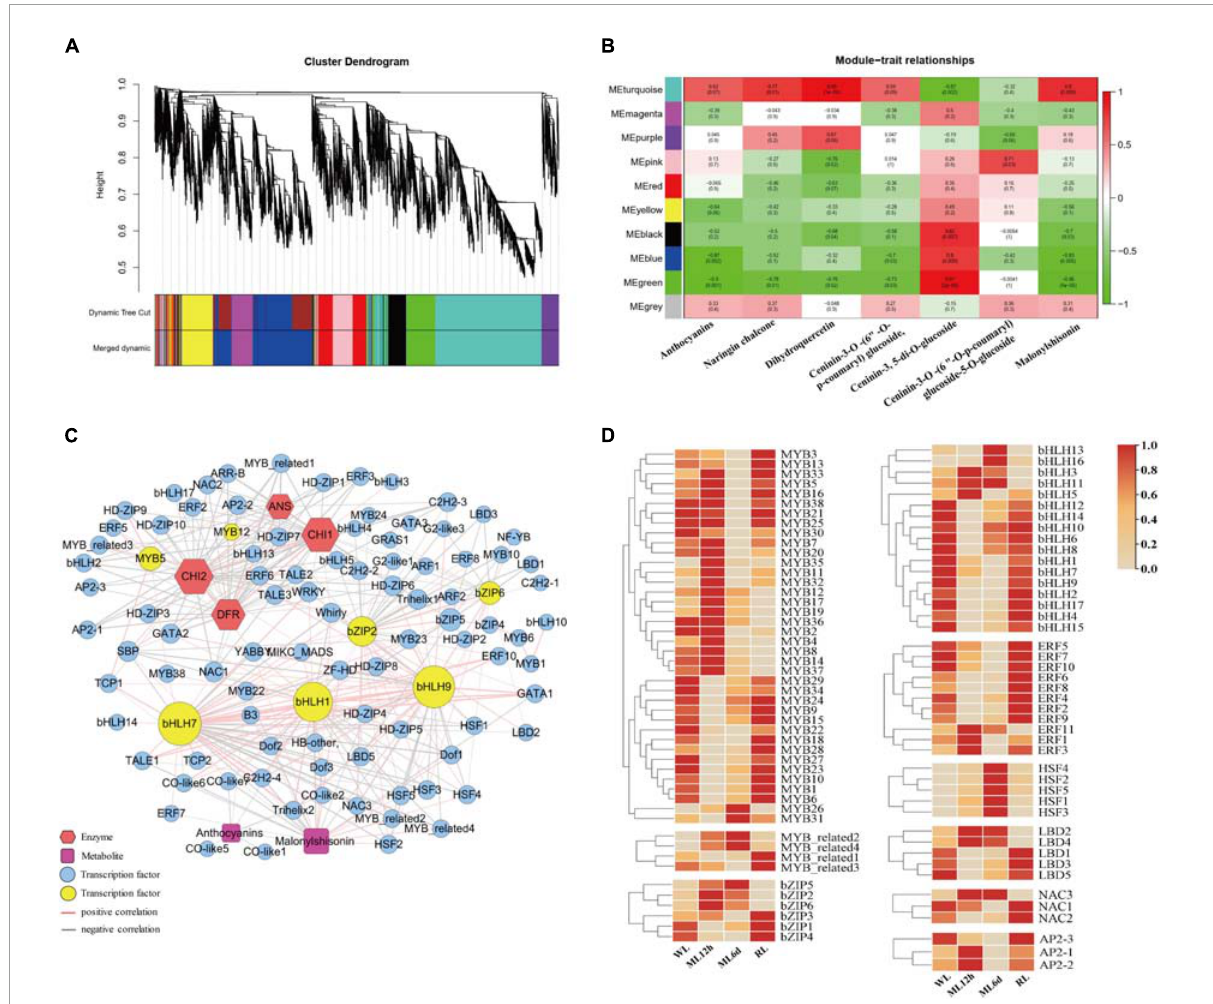
FIGURE5 Weighted correlation network analysis (WGCNA) of the anthocyanin biosynthetic pathway. (A) Dendrogram of the co-expression modules (clusters). The major tree branches constitute 10 modules labeled with different colors. (B) Heat map showing the correlations between modules and anthocyanin compounds. Red indicates a positive correlation, and green indicates a negative correlation between the cluster and the sample. (C) Co-expression network of the genes and metabolites with correlation coefficients greater than 0.85. (D) Heat maps of the expression levels of genes encoding MYBs, MYB-related, bZIPs, bHLHs, ERFs, HSFs, LBDs, NACs, and AP2s based on the transcriptomic data.